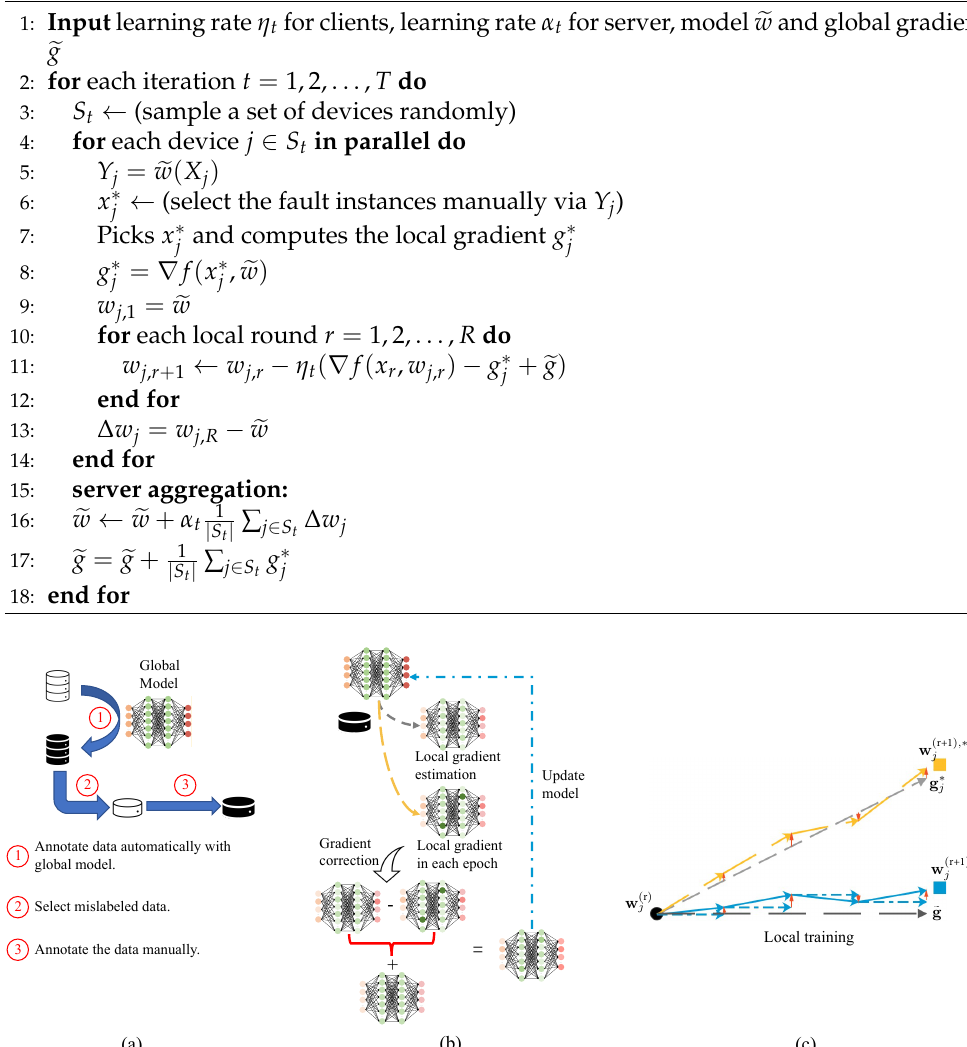
Algorithm 1 Semi-FAL: Semi-Federated Active Learning with Unlabeled Data